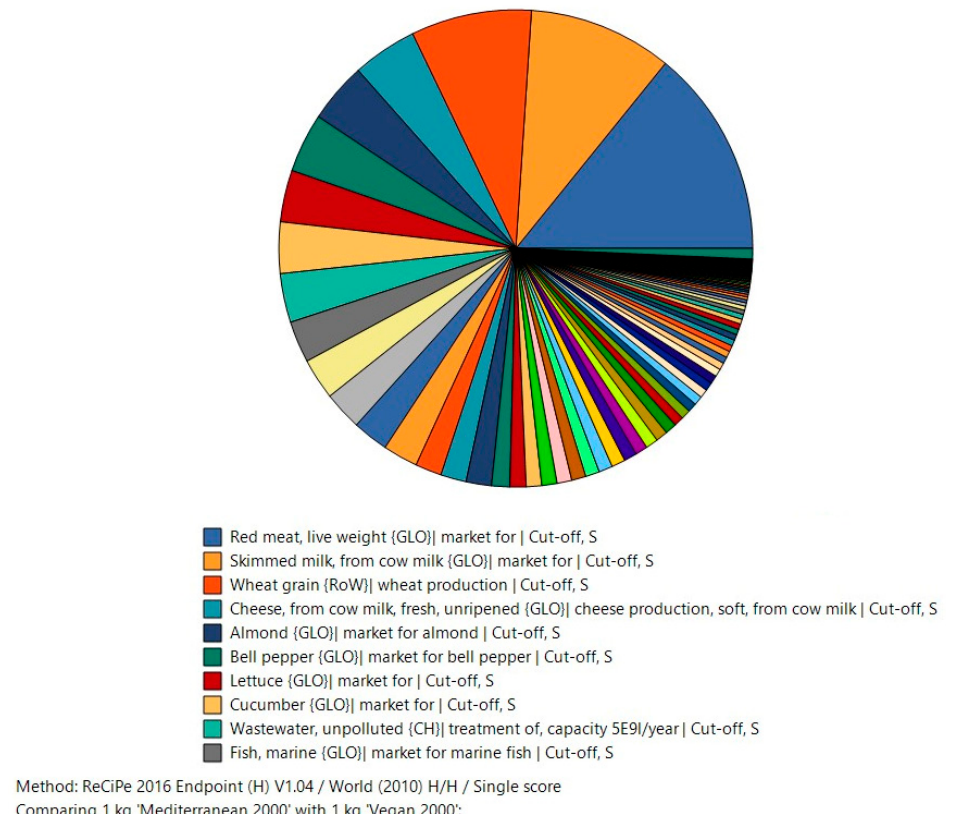
Figure A2. Mediterranean diet’s process contribution (cake). The contribution of each food group is calculated on a 100% scale (cut off 0.1%).